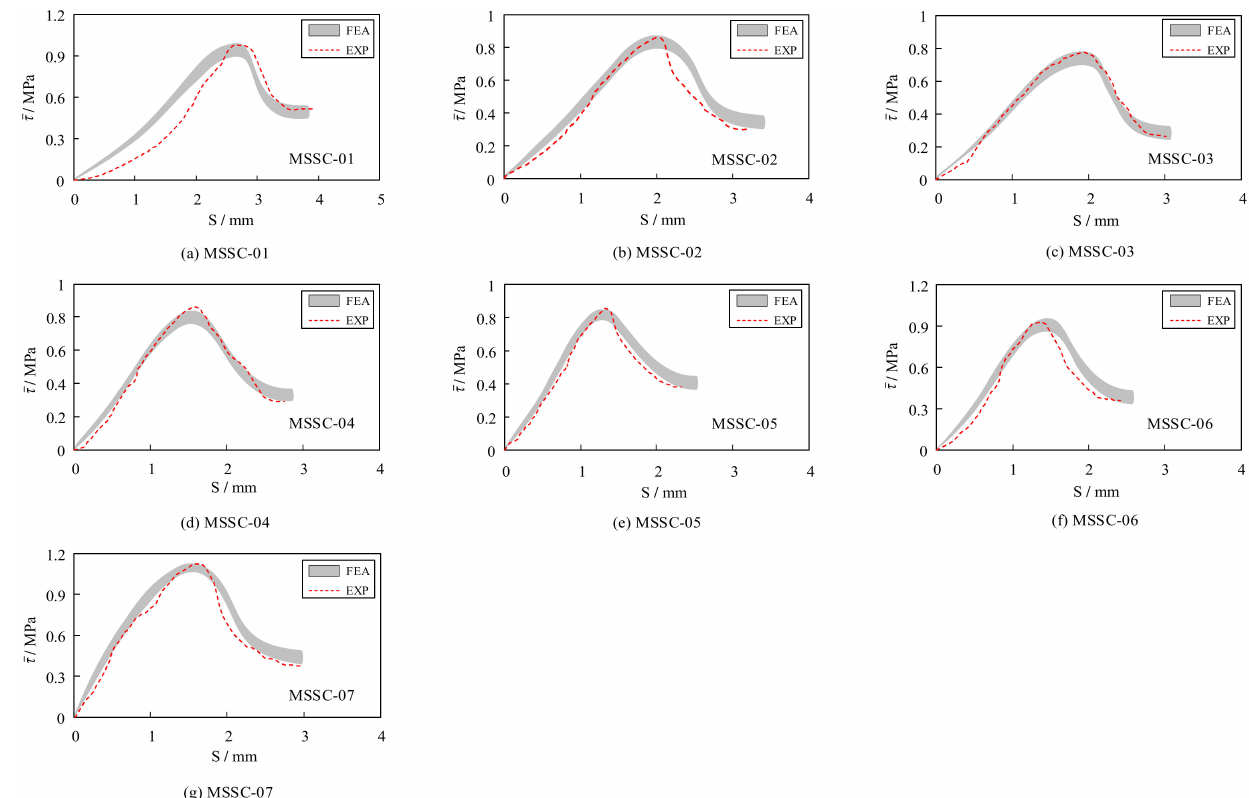
Figure 21. Comparison between FEA and EXP bond–slip curves.